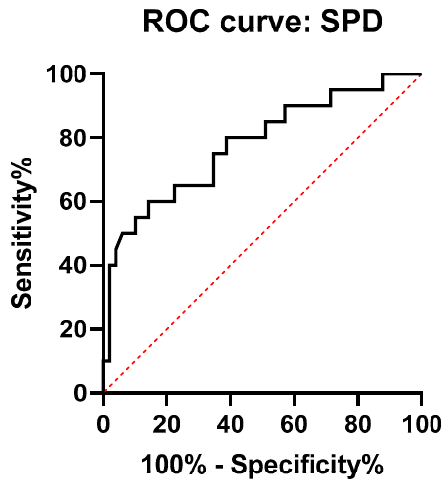
Figure 3. Receiver operating characteristic (ROC) curve of diagnostic performance of SPD serum levels in the identification of HRCT abnormalities. Table 4. Logistic regression model for predictors associated to the presence of HRCT abnormalities.